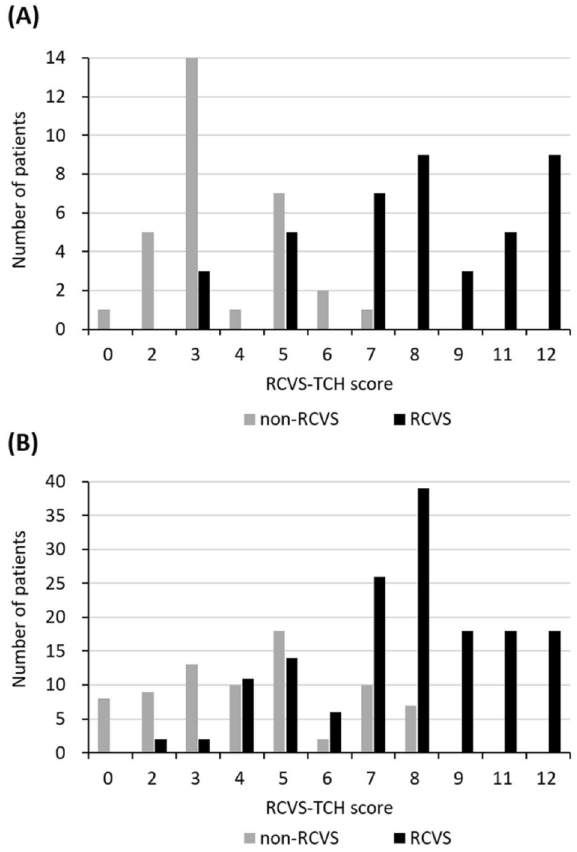
Figure 3. Distribution of the RCVS–TCH scores in the derivation and validation datasets. Histograms show the distribution of the RCVS–TCH score between the RCVS and non-RCVS groups in each derivation ( A ) and validation ( B ) set. Black bars indicate the number of patients with RCVS, and grey bars indicate the number of patients with